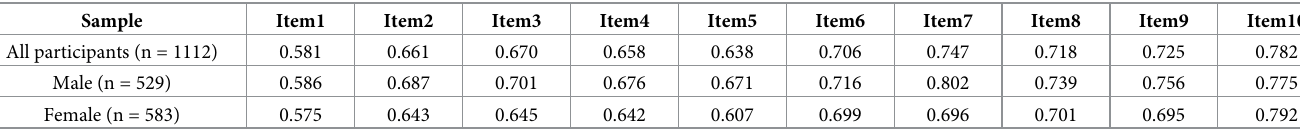
Table 3. Results of single-group confirmatory factor analysis (standardized factor loadings).